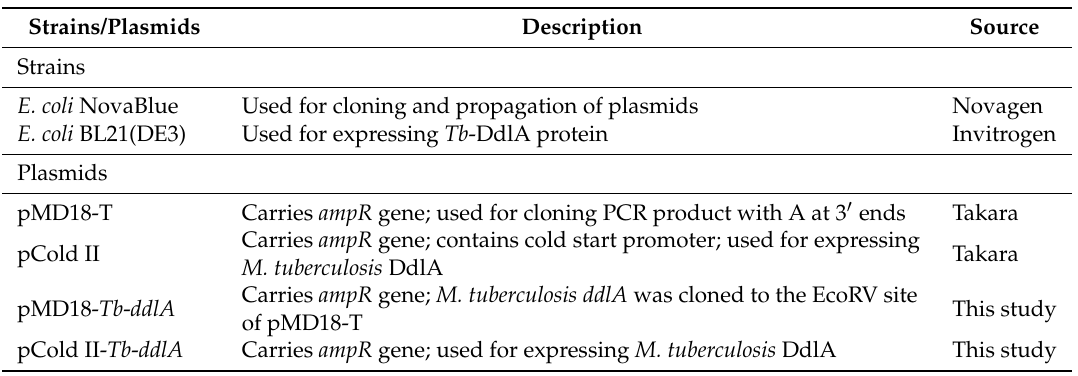
Table 3. Bacterial strains and plasmids used in this